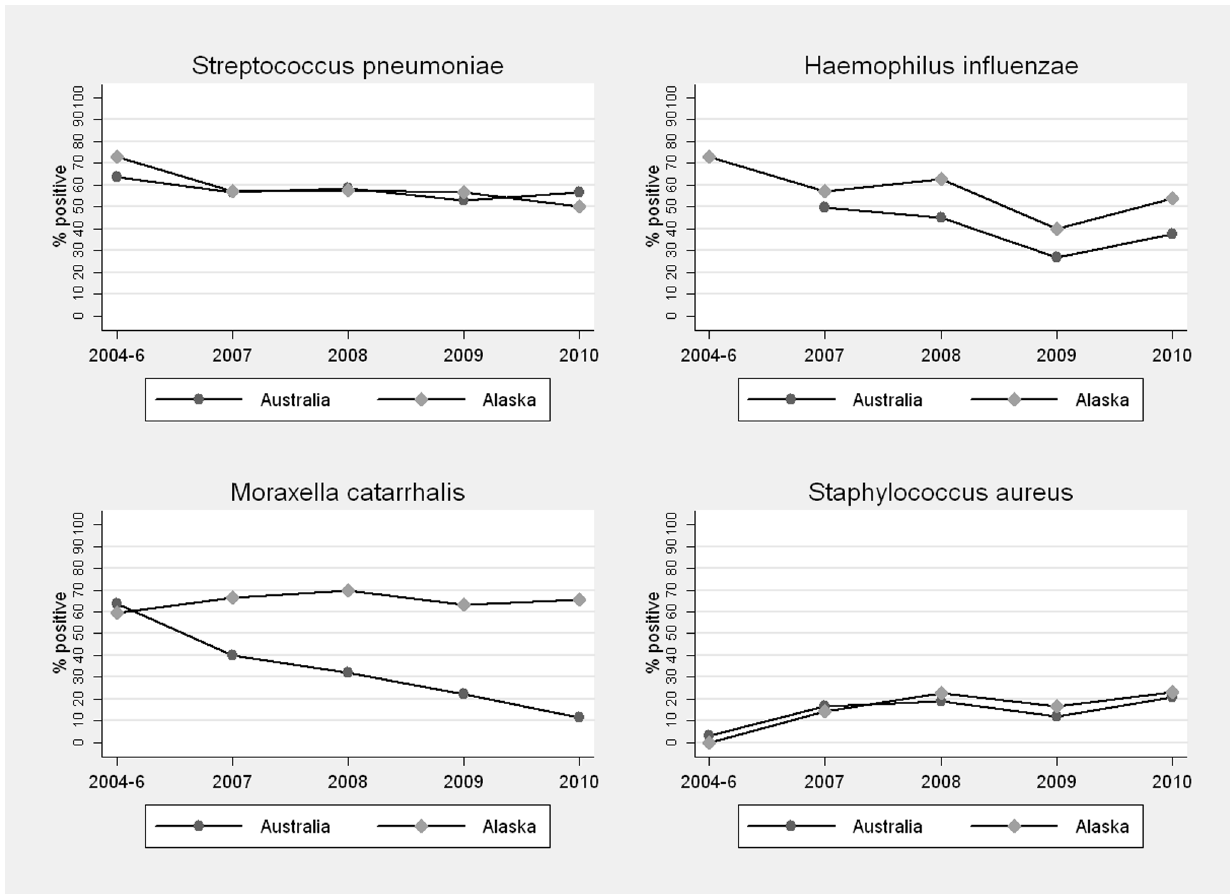
Figure 1. Pathogen carriage (proportion of swabs) by study year in Australian and Alaskan children.